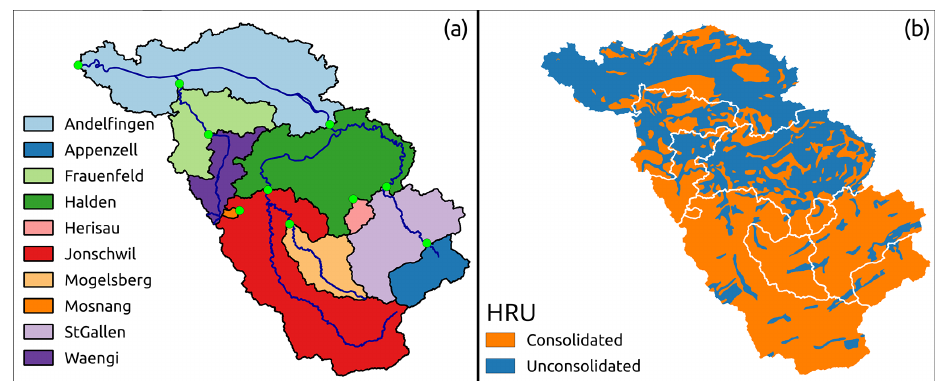
Figure 7. Illustration of catchment discretization used for a distributed application of SuperflexPy in the Thur catchment: (a) discretization into sub-catchments and (b) discretization into hydrological response units (HRUs) as presented in model M02 in Dal Molin et al. (2020). The panels of this figure were originally published in Figs. 1a and 6 of Dal Molin et al. (2020). The HRU model structure is shown in Fig. 8.